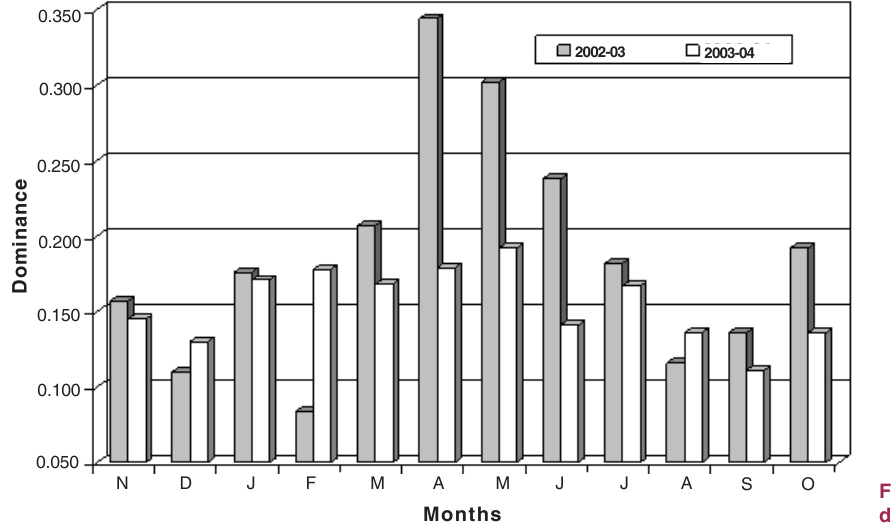
Figure 8. Monthly variations in dominance of